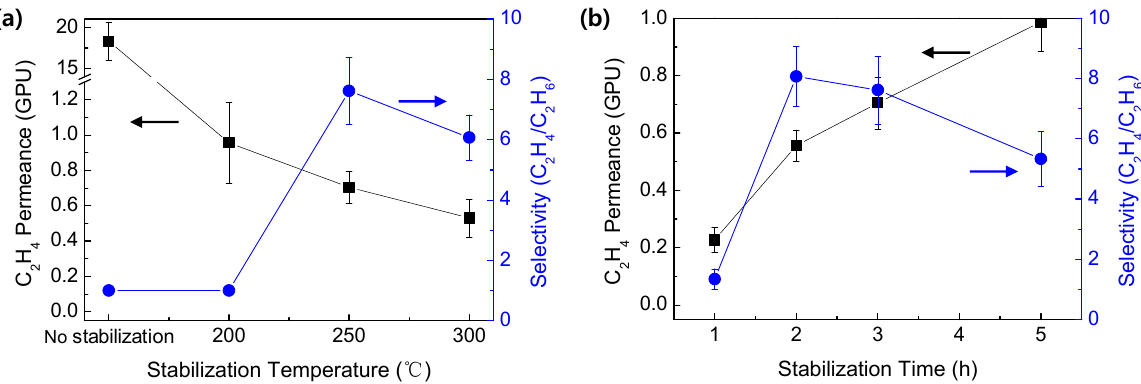
Figure 7. Ethylene/ethane mixed gas separation performance of CMS membranes prepared in a variety of ( a ) stabilization temperature (stabilization time: 3 h) and ( b ) stabilization time (stabilization temperature: 250 °C).